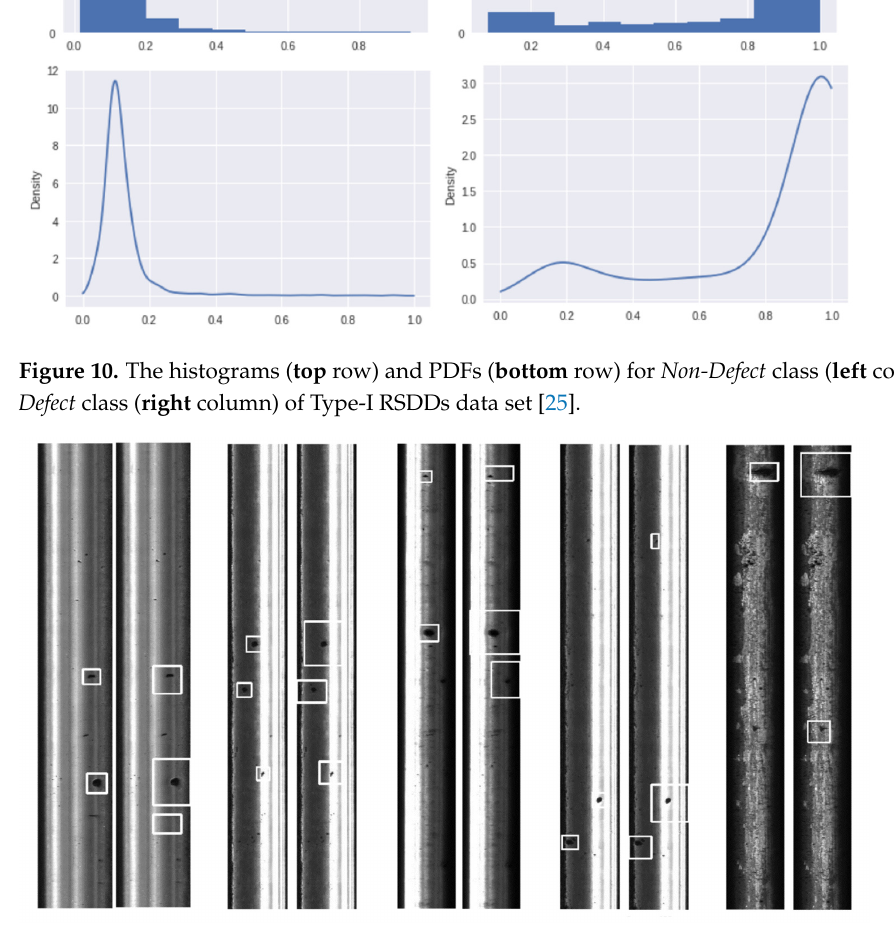
Figure 11. Five pairs of defect detection results of the proposed approach (Type-I RSDDs data set [25]). Each pair of results consists of the ground truth bounding boxes ( left ) and detected bounding boxes ( right